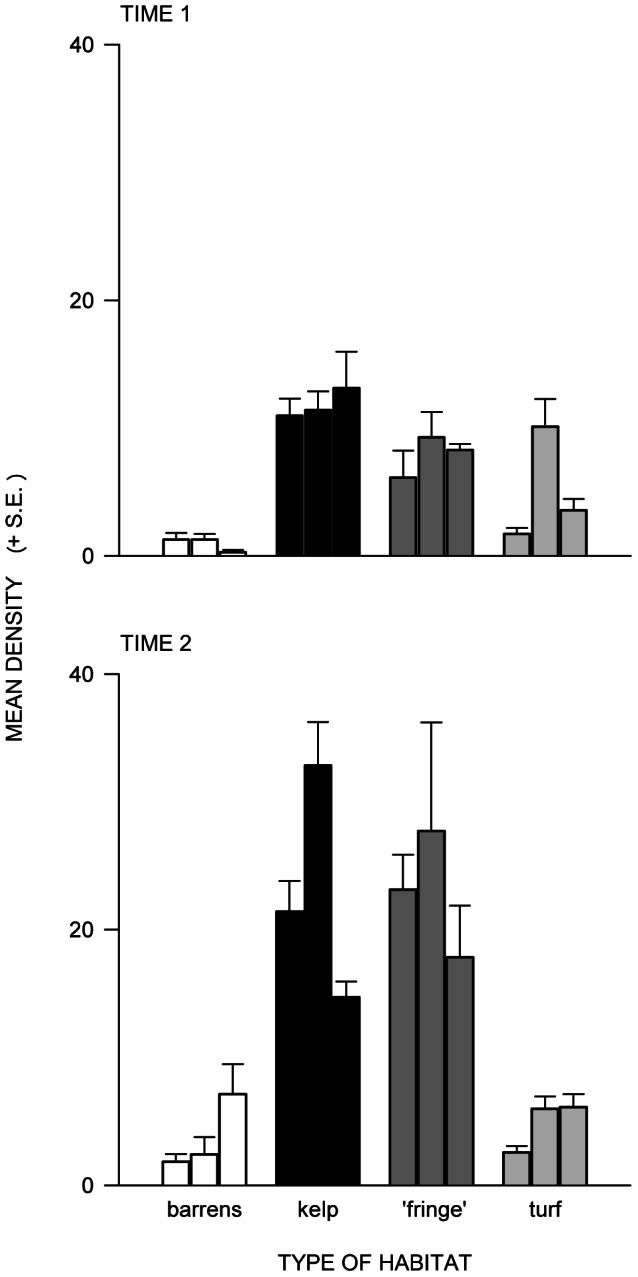
Mean density of Turbo torquatus on subtidal rocky reefs.Mean density (+ S.E.; n = 7) of T. torquatus in 5×1 m transects in each of three representative sites of each habitat at Cape Banks at (a) time 1 and (b) time 2.